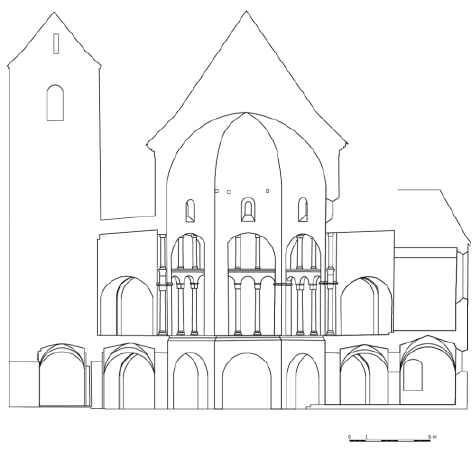
Figure 15. Manually digitized sectional view